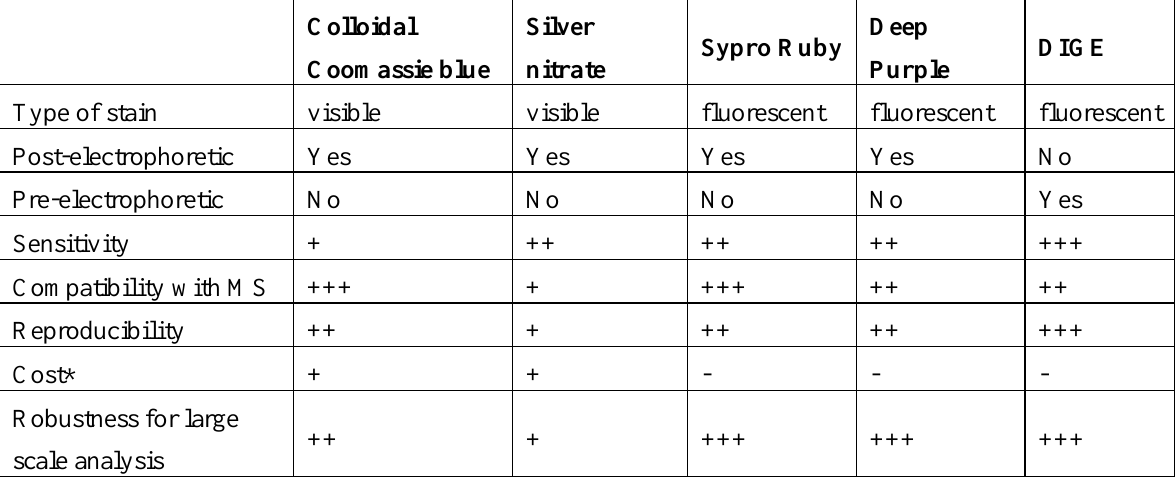
Table 1. Comparison of analytical performances of standard dyes used for total protein staining in gel-based proteomic analysis. * cheap (+) or expensive